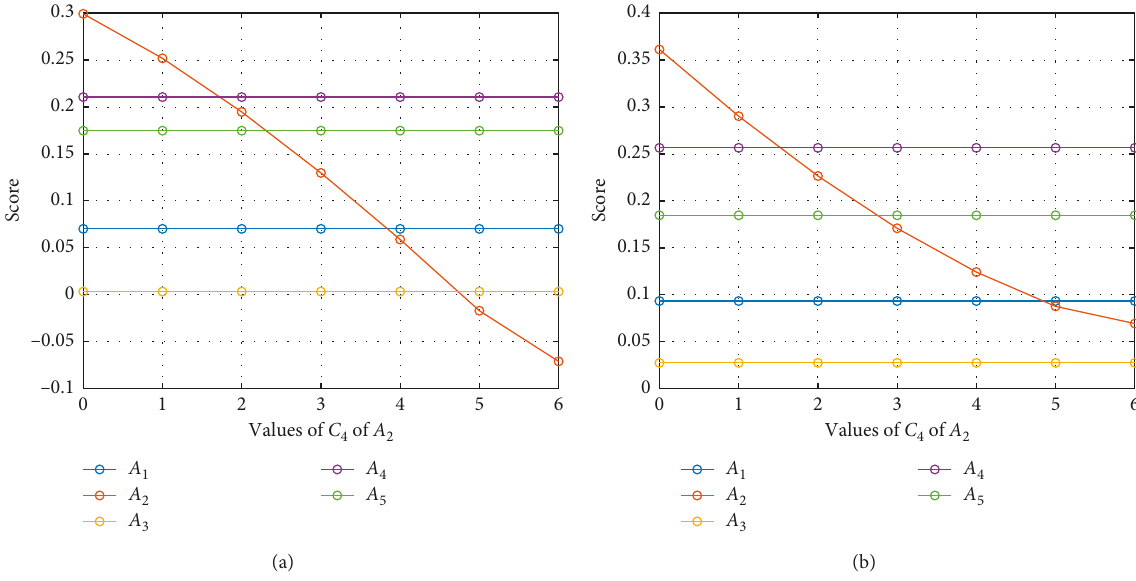
Figure 8: The change of the places of A 2 in the rankings of the group of WAMMs and the group of WAGMMs. Scores of the five companies computed by the group of (a) qROFWAMMs and (b)